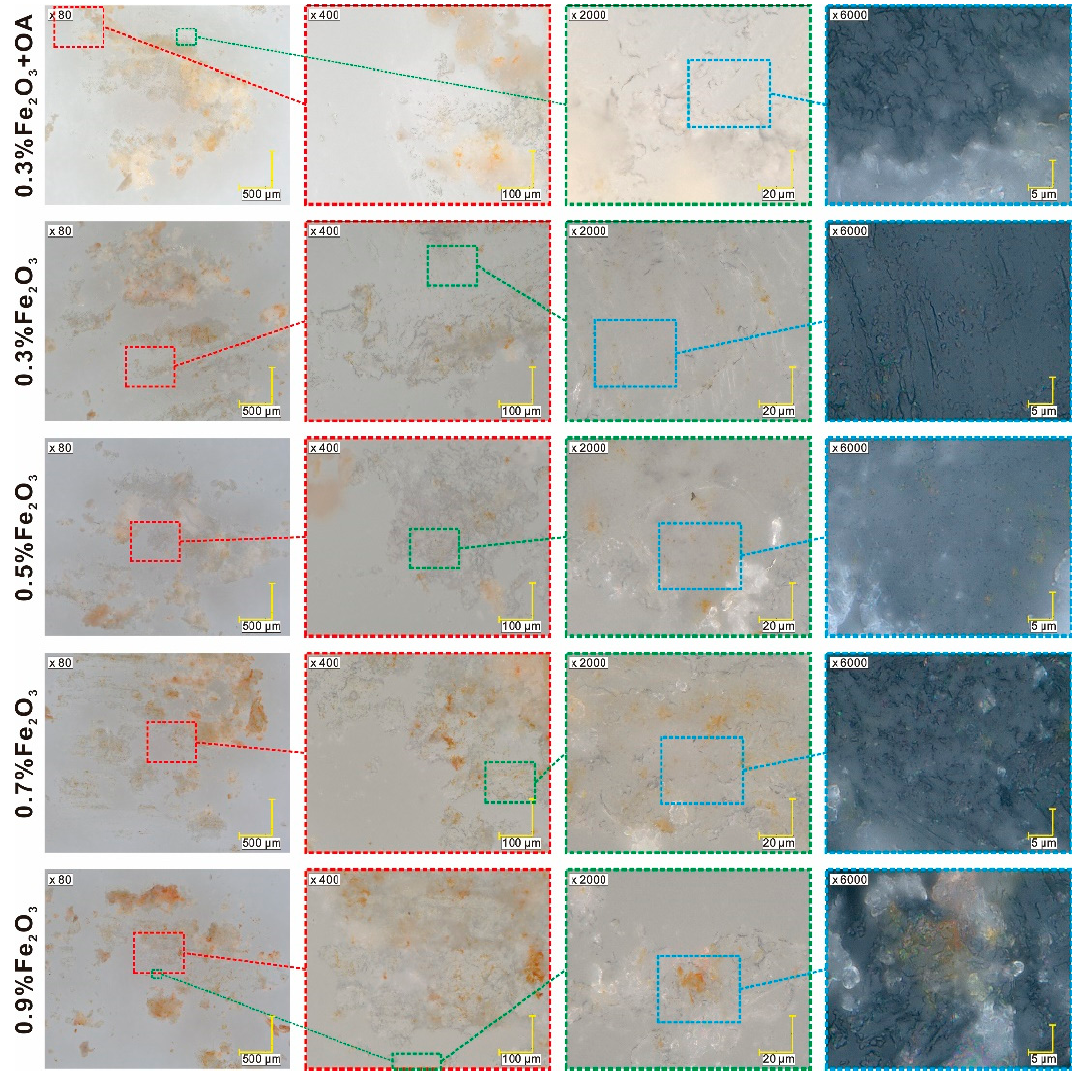
Figure 3. Digital optical images of Composites 1–5. The magnification is shown in the images, where colored dotted squares correspond to the enlarged areas.